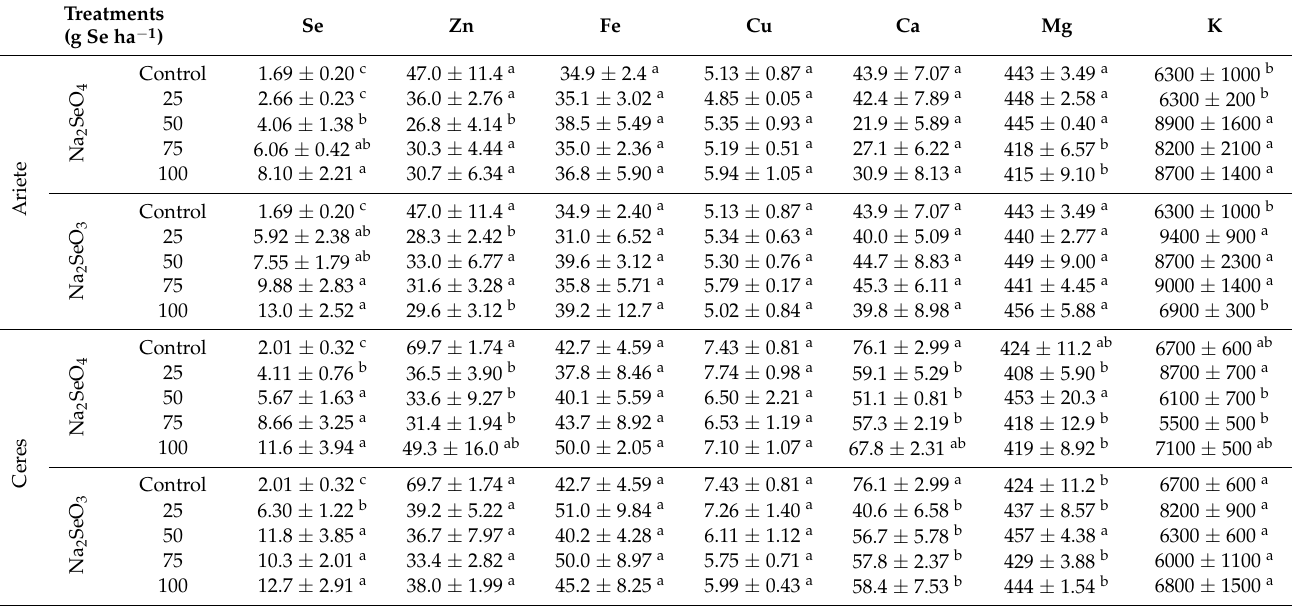
Table 1. Selenium, zinc, iron, copper, calcium, magnesium and potassium concentrations in the paddy grains of O. sativa cultivars. Treatments (g Se ha − 1 )